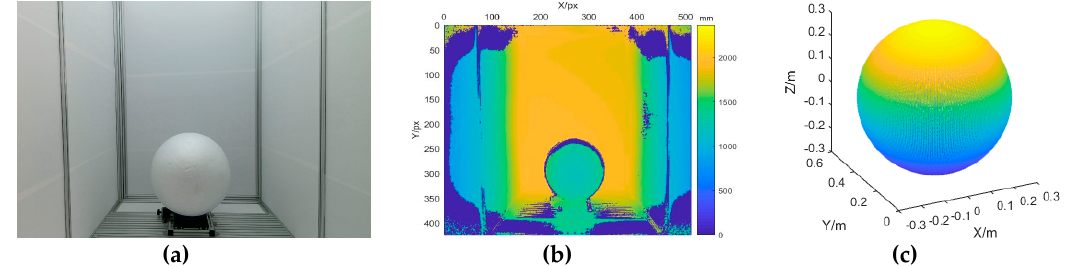
Figure A1. Reconstruction of a 3D point cloud of the standard Styrofoam ball (SSB) with a diameter of 60 cm: ( a ) color image of the SSB; ( b ) depth image of the SSB; ( c ) reference point cloud of the SSB.